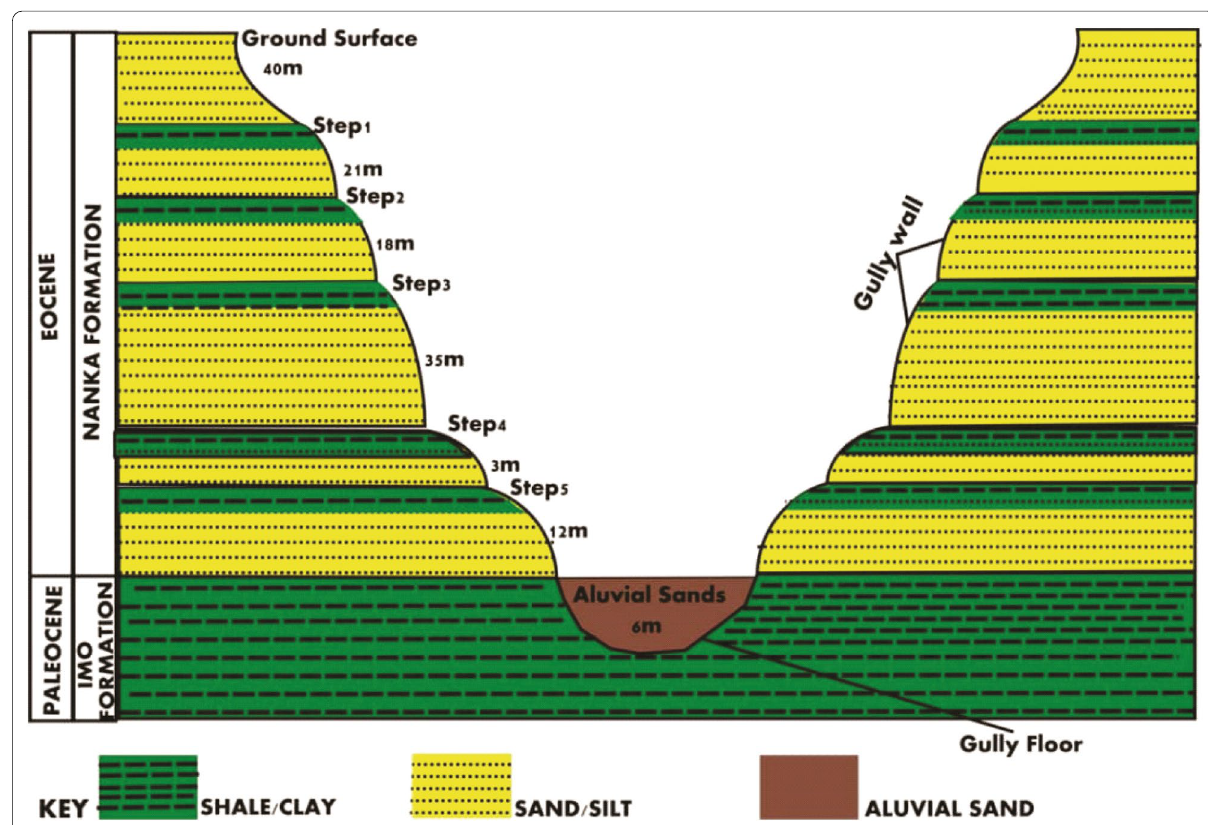
Fig. 10 Step-like erosion model displaced in the majority of the affected areas where Nantra Formation outcropped in the study